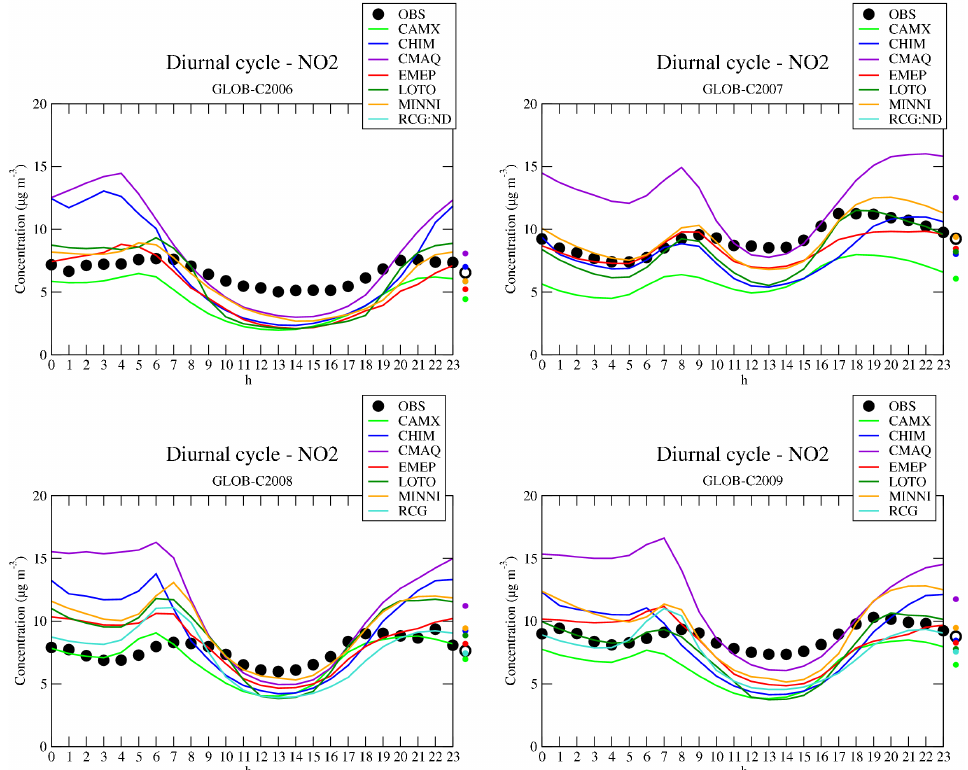
Figure 9. Mean diurnal cycles of nitrogen dioxide for all campaigns simulated by the models compared with observations. Averaged con- centrations are provided on the right side of the charts.